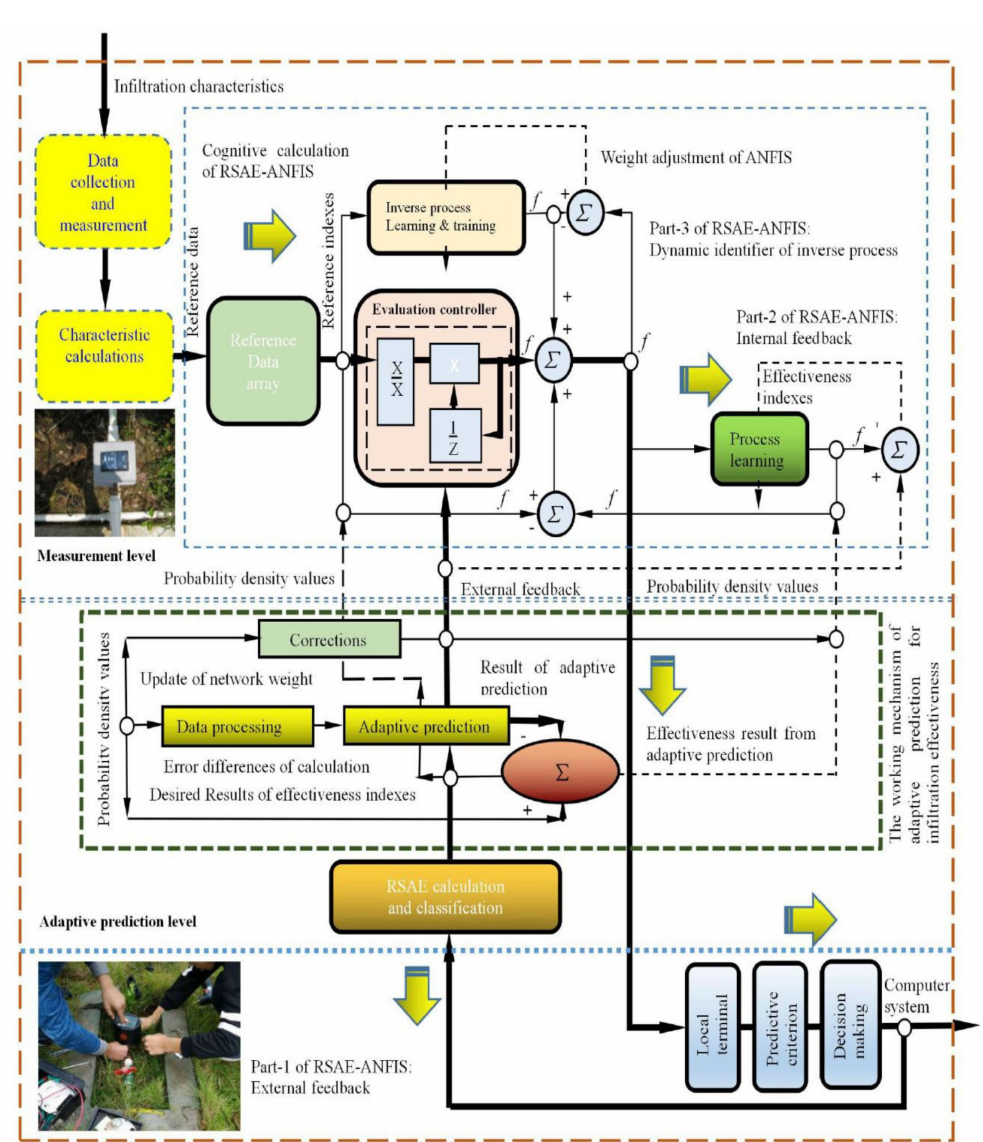
Figure 4. Diagram of RSAE–ANFIS computational mechanism in which the droplet infiltration properties could be computed and determined for the interests of adaptive